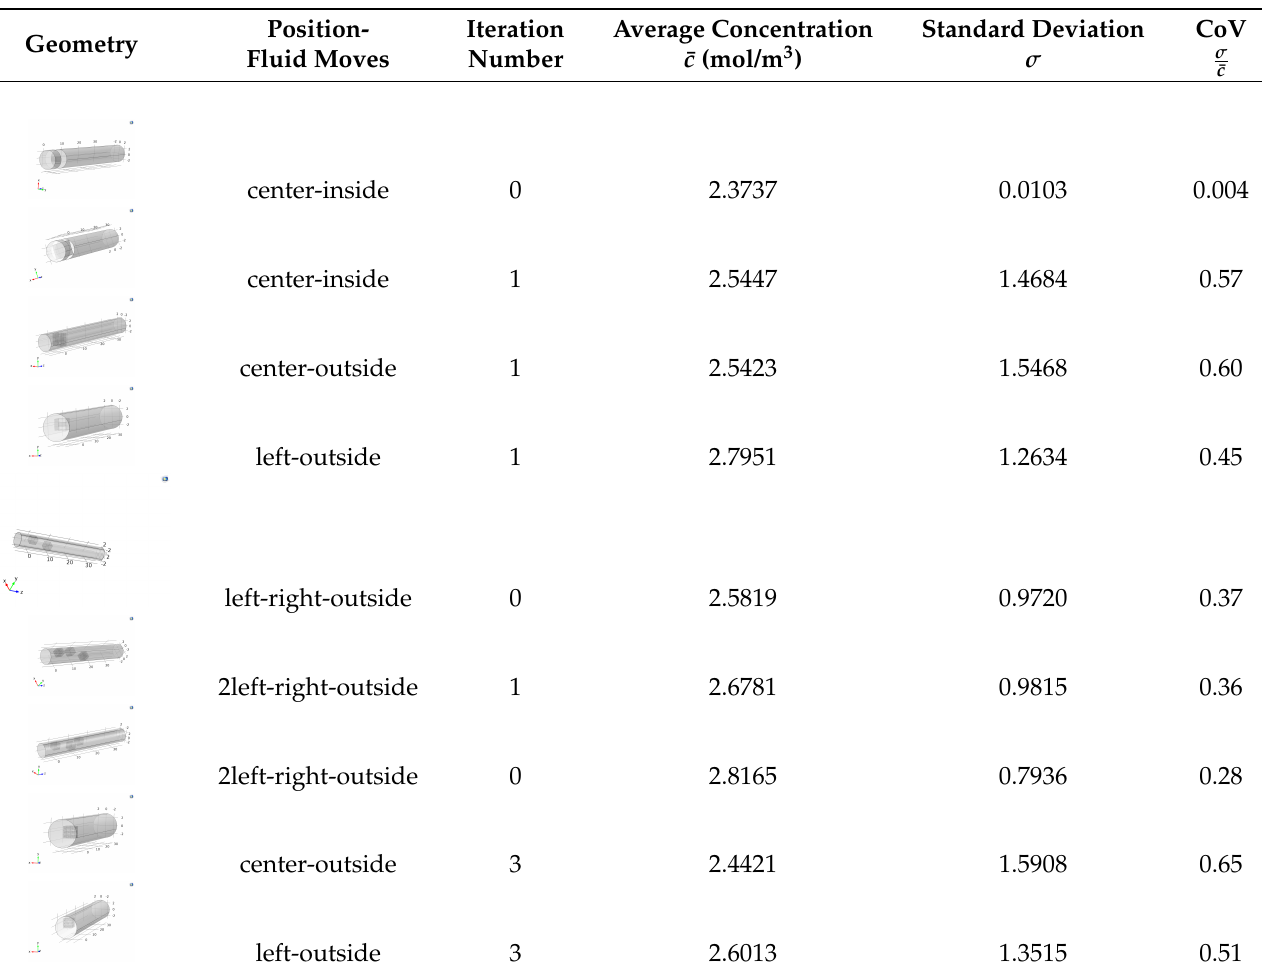
Table 1. Values of CoV, which indicates the quality of mixing the two fluids using Sierpinski carpet patterns and obstacles with a square